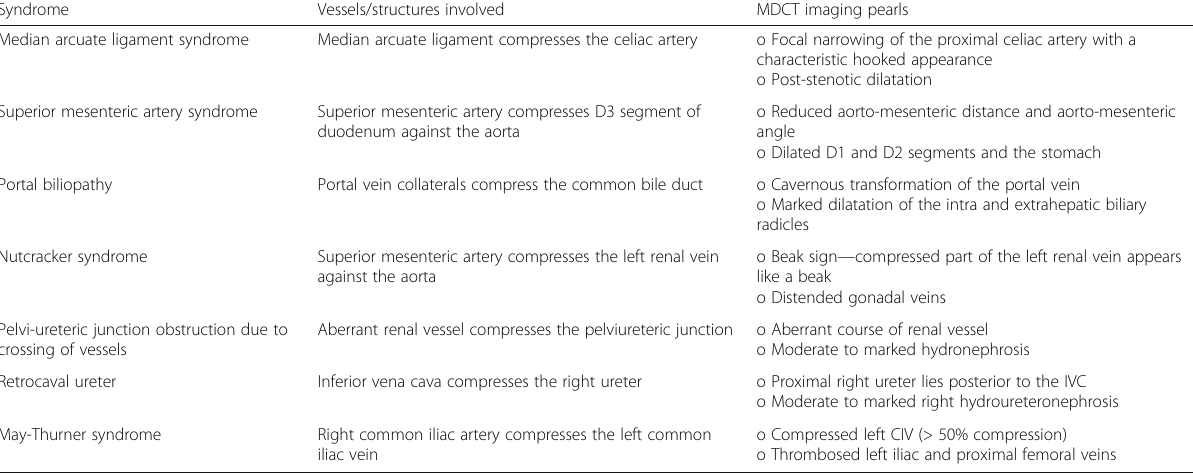
Table 1 Imaging findings of the various vascular compression syndromes of the abdomen and